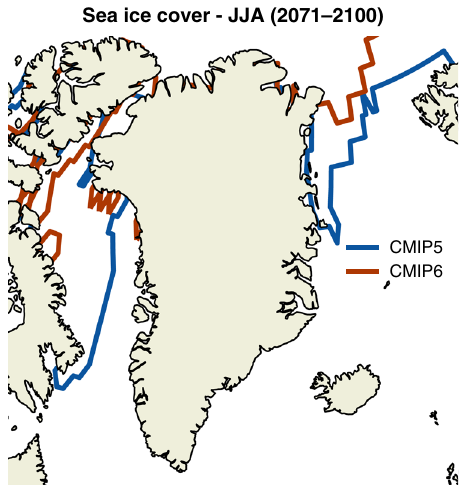
Fig. 8 Difference in JJA sea ice coverage between 5 CMIP6 and 6 CMIP5 models used in the downscaling with MAR. Thirty-year average (2071 – 2100) location of the southern edge of the continuous Arctic sea ice cover around Greenland in JJA — computed as the boundary where the sea ice concentration ( “ sic ” or “ siconc ” variable) of the GCMs is greater than 15% as used in ref. 47 .